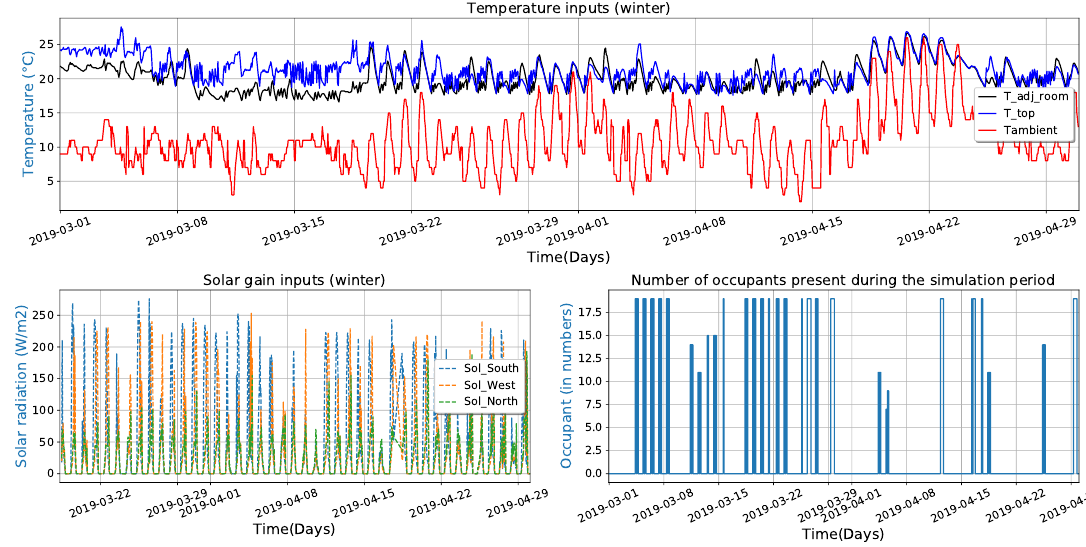
Figure 14. Measured inputs of the model: ambient and adjacent zones temperatures, solar irradiation, and occupant numbers (winter).